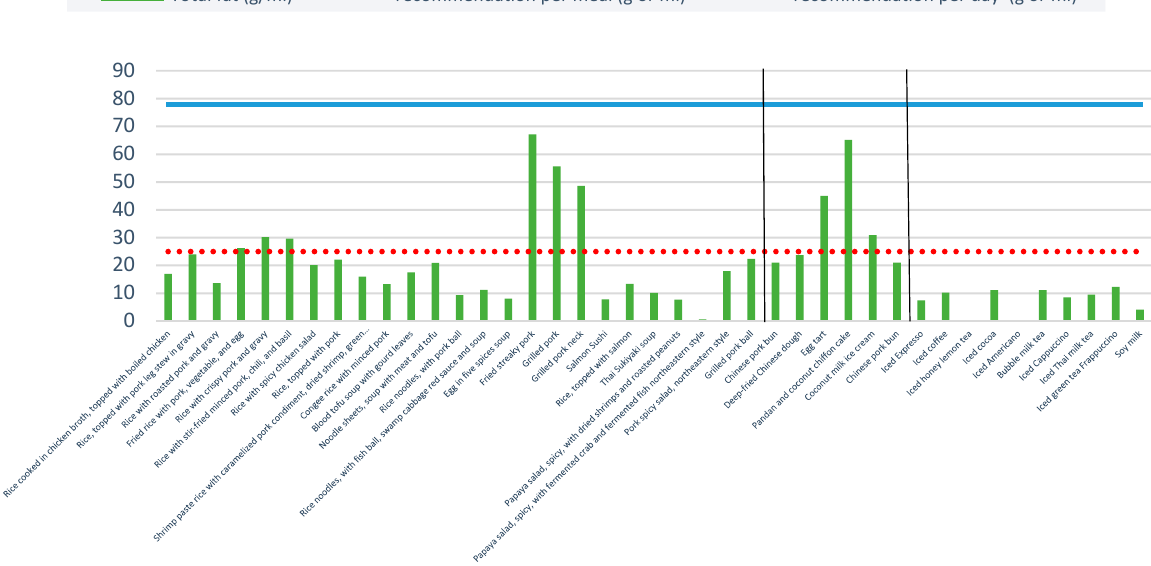
Figure 3. Total fat content per portion of the 40 menu items. Note: Two vertical blacks line separate the three food types: ready-to-eat items, sweets, and non-alcoholic beverages.